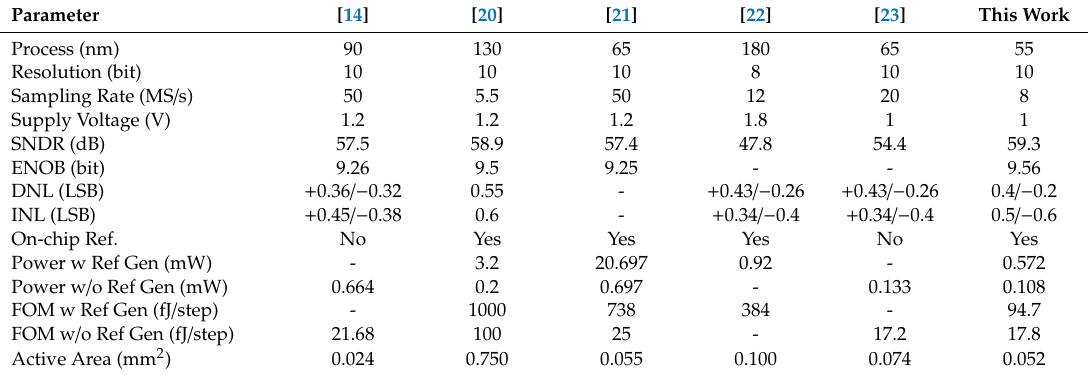
Table 1. Performance